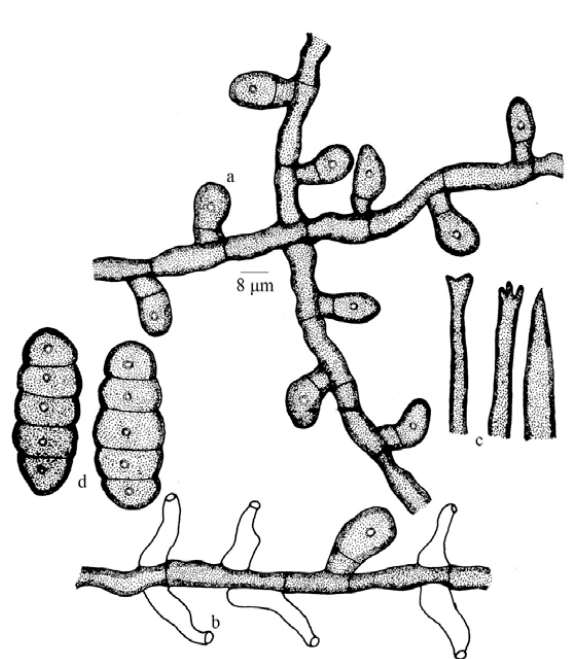
Figure 14. Meliola parishiae sp. nov. a - Appressorium, b - Phialide, c - Apical portion of the mycelial